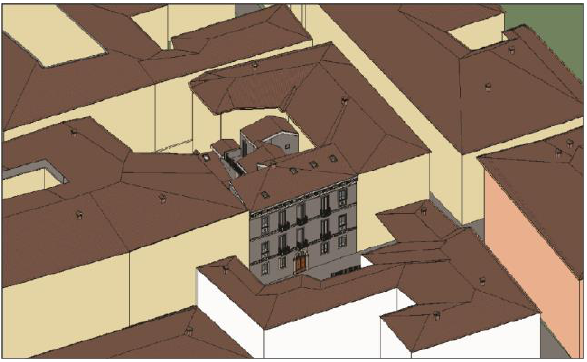
Figure 2. This picture show the model called As Is, got through scan to BIM